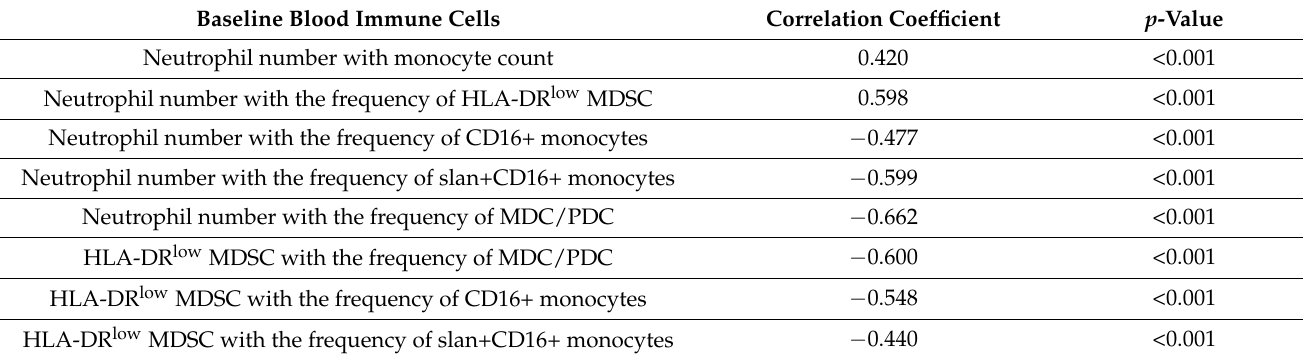
Table 4. Association of baseline blood immune cell parameters analyzed by Spearman’s rank